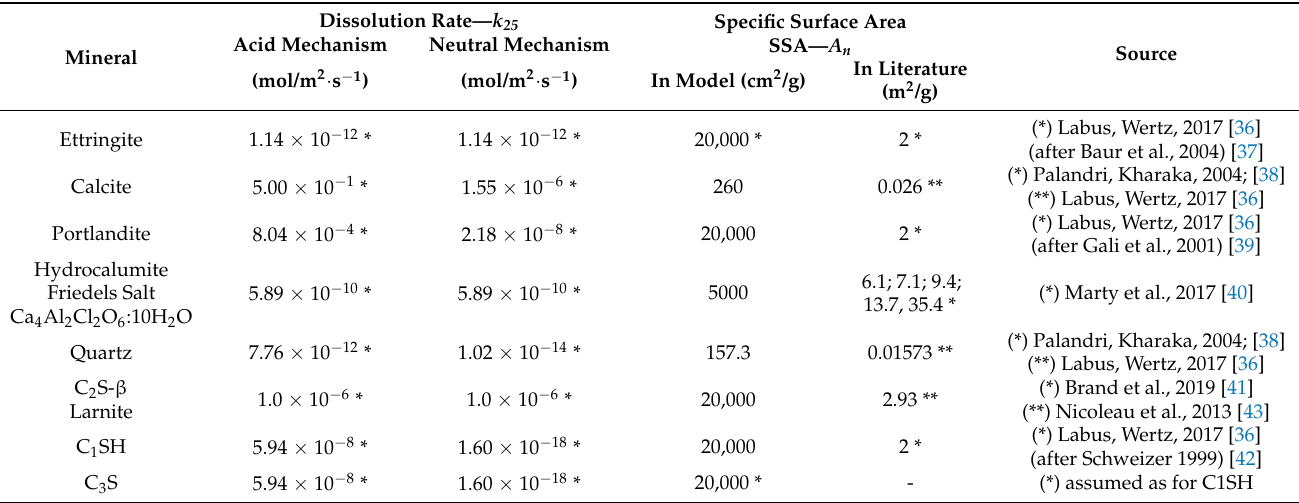
Table 3. Kinetic reaction parameters for the temperature of 25 ◦ C and specific surfaces of mineral grains adopted for modeling.